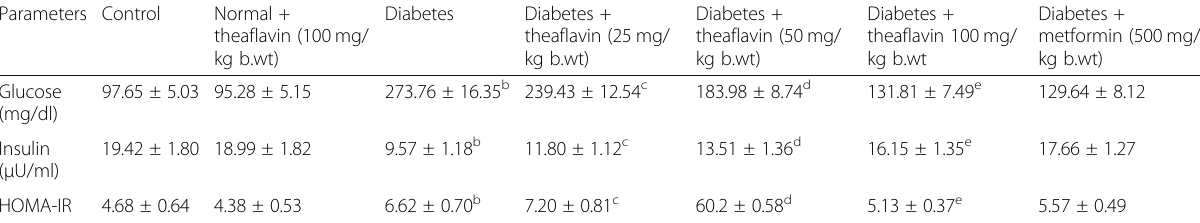
Table 1 Dose-dependent effect of theaflavin on blood glucose, insulin levels, and HOMA-IR index in control and experimental animals Parameters Control Normal + theaflavin (100 mg/